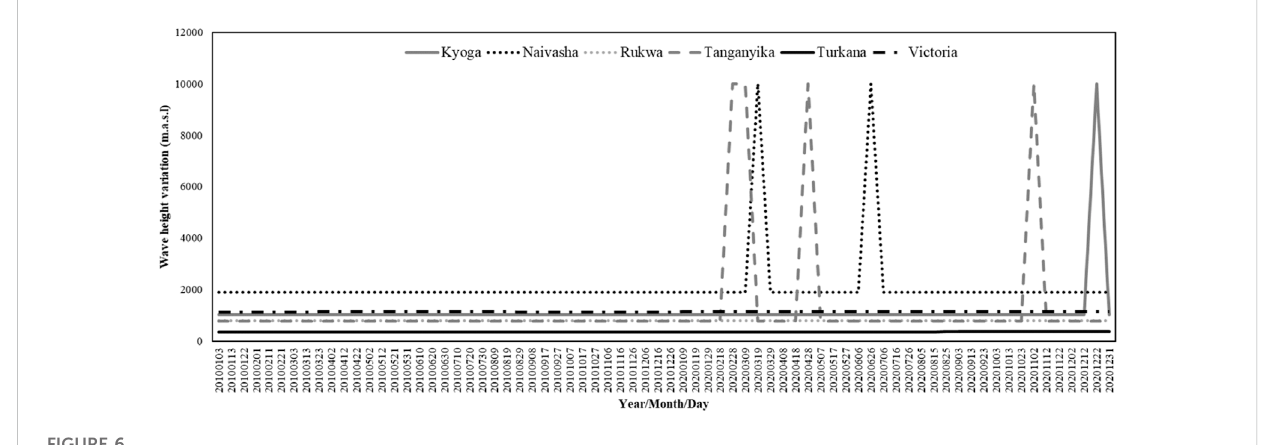
FIGURE 6 Smoothened wave height variations in selected lakes based on the availability of altimetry